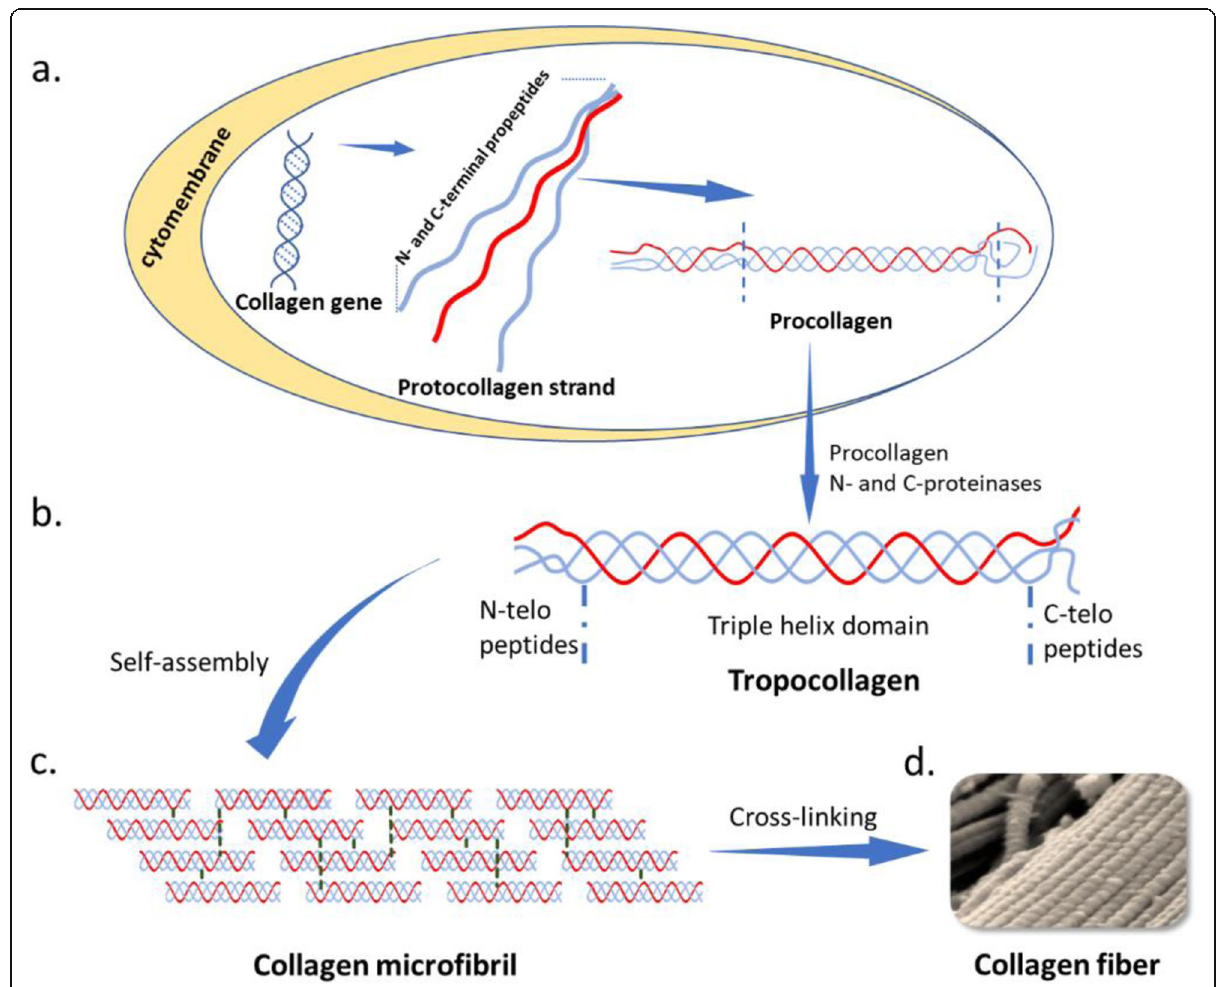
Fig. 2 Biosynthetic route of type I collagen in vivo